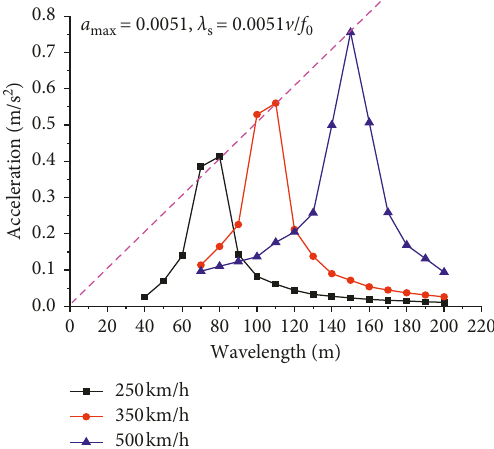
Figure 11: Vehicle vertical accelerations at different train speeds.